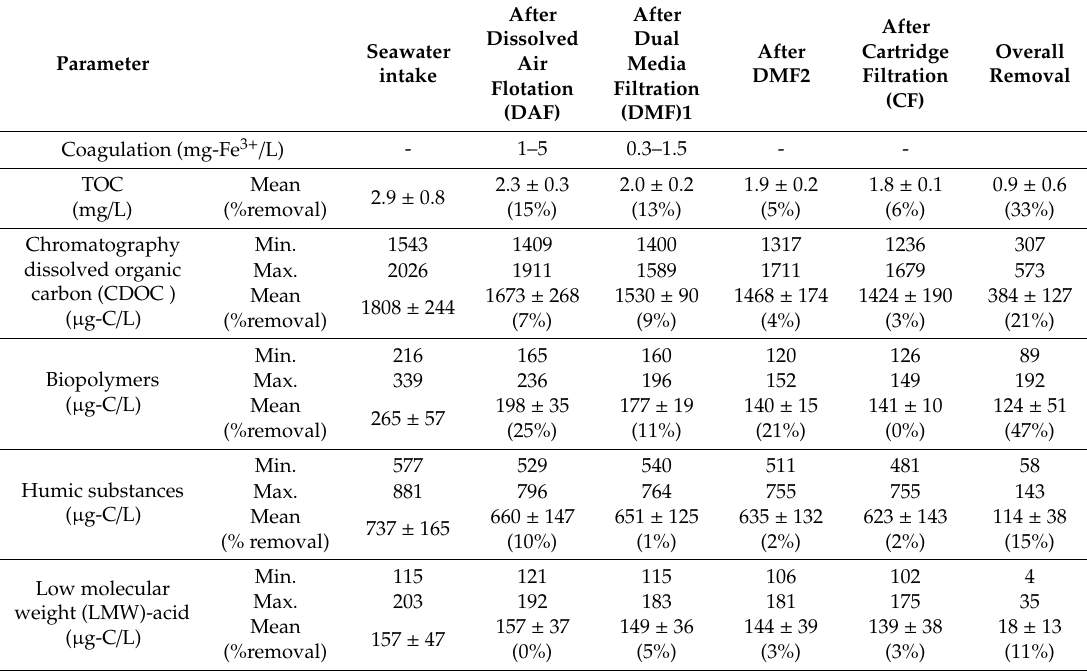
Table 4. Removal of total organic carbon *(TOC) (n = 12) and various fractions of organic carbon (n = 5) along the pre-treatment of SWRO desalination plant over 5 months